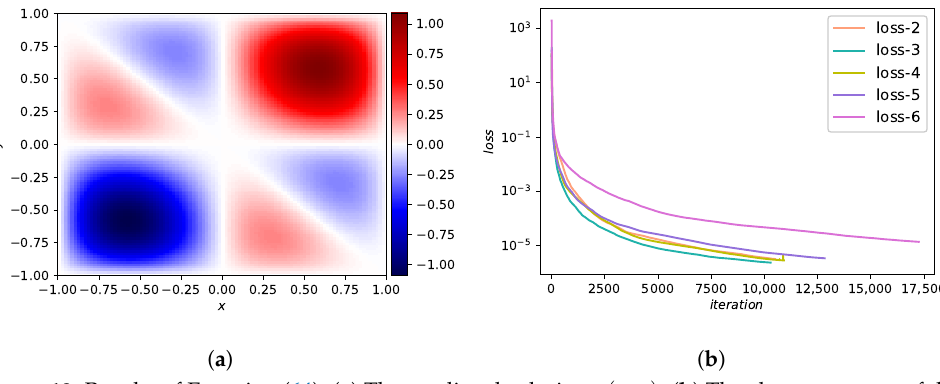
Figure 18. Results of Equation (64). ( a ) The predicted solution u ( x , y ) . ( b ) The change process of the objective function versus iteration